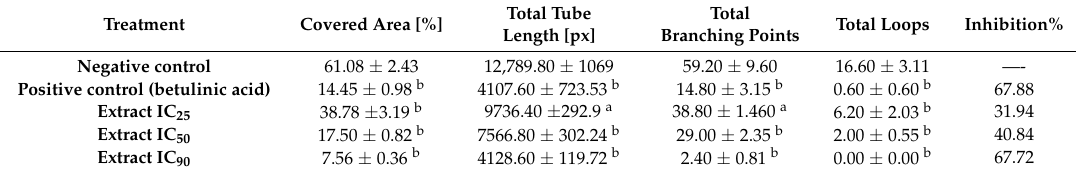
Table 2. The effects of 50% ME of P. niruri extract towards different parameters of tube formation. Treatment